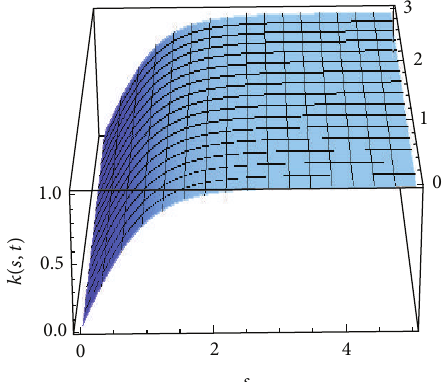
Figure 3: The curvature of the family of curves 𝐶 𝑡 for 𝑠 ∈ [0, 5] , 𝑡 ∈ [0, 3] , 𝑎 = 0.6 , 𝑐